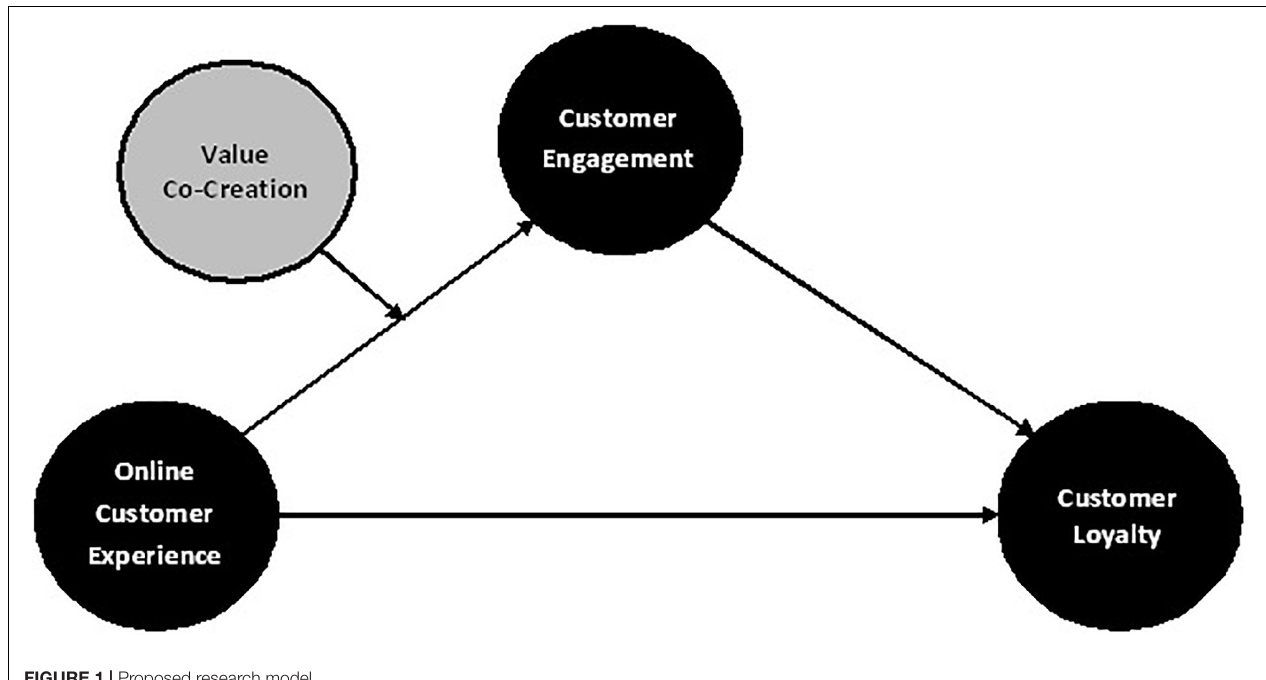
FIGURE 1 | Proposed research